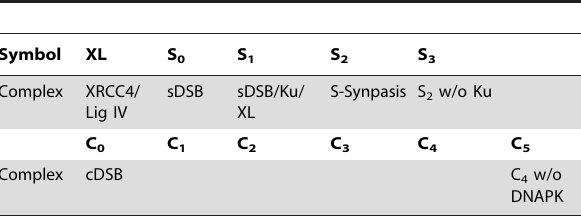
Table 1. Notation for the complexes involved in the NHEJ repair of simple and complex